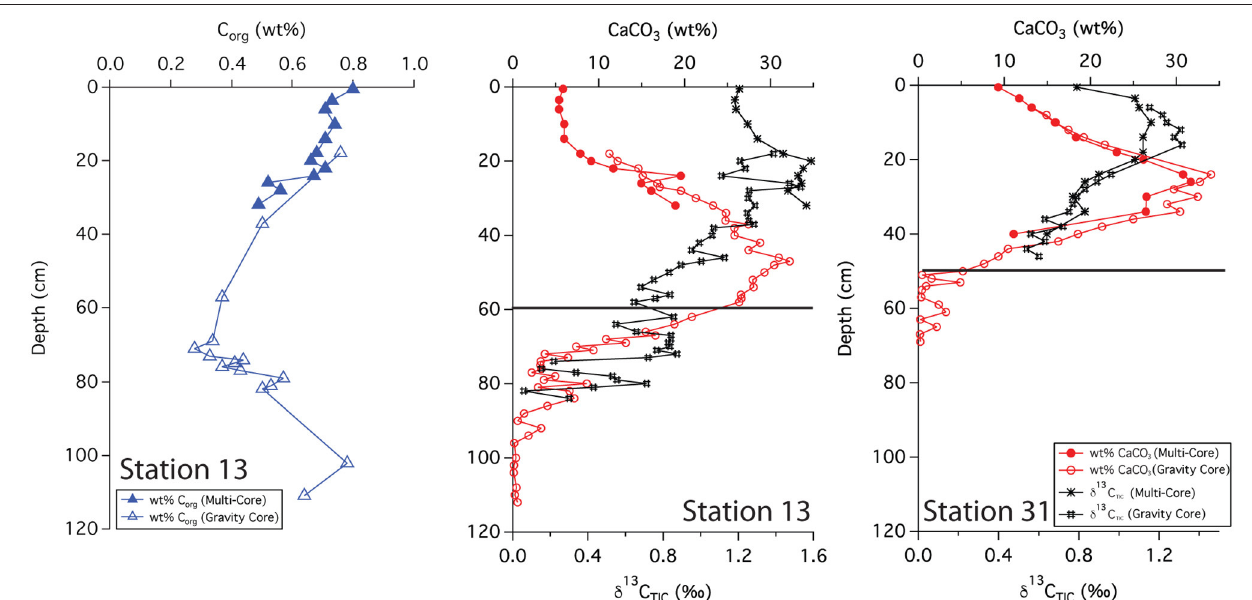
FIGURE 3 | Downcore profiles of C org , CaCO 3 and δ 13 C(TIC). Black lines indicate the depth of the indurated iron crust.